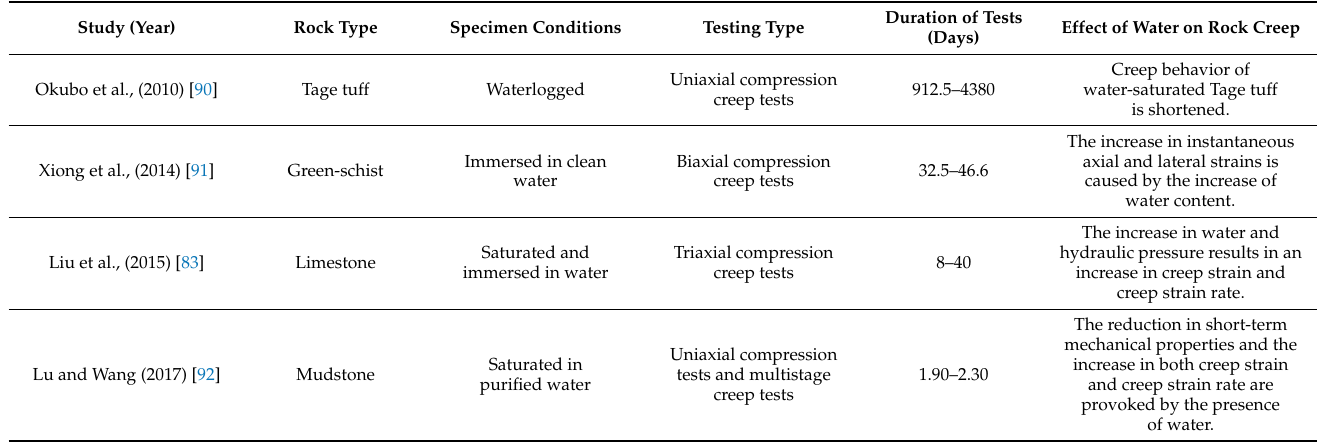
Table 1. Summary of the effects of water on the creep behavior of rocks (adapted from [89]). These data are taken into account given that the rock samples were mainly collected from deep rock tunnels, and also because of the available relevant studies. The maximum duration or duration range of the tests is provided to better understand the